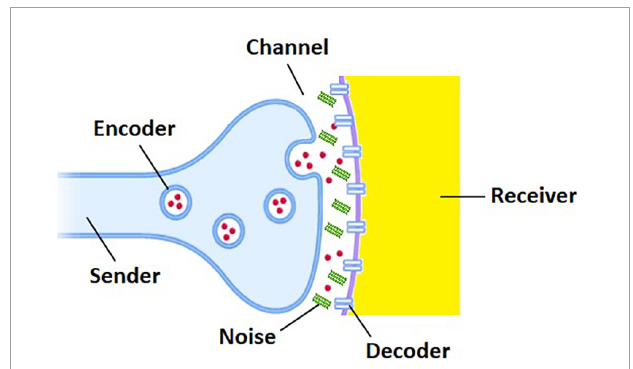
FIGURE1 Shannon–Weaver model of communication for neurotransmission disrupted by the presence of A β oligomers (green bars) in the synaptic cleft between presynaptic (blue) and postsynaptic (yellow) neurons. Red circles and blue bars represent neurotransmitters and receptors,